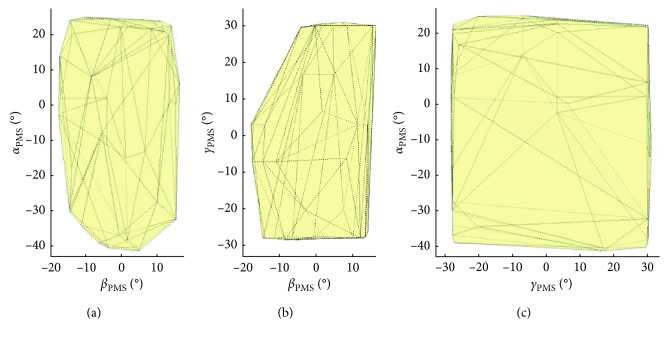
Projections of PMS at the coordinate {oan}. (a) Plane xanoanyan. (b) Plane yanoanzan. (c) Plane xanoanzan.